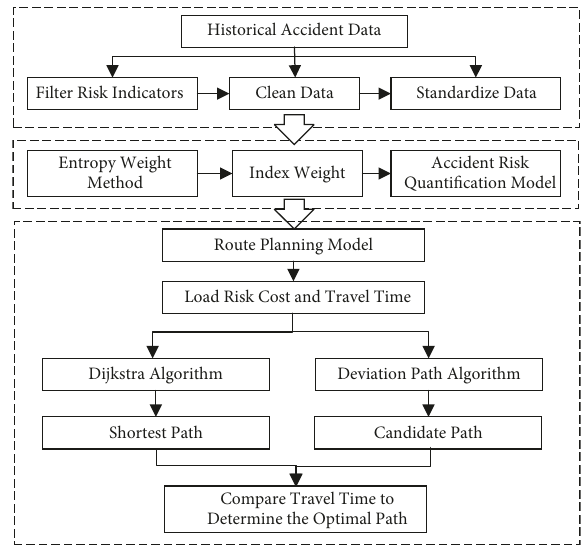
Figure 1: Research